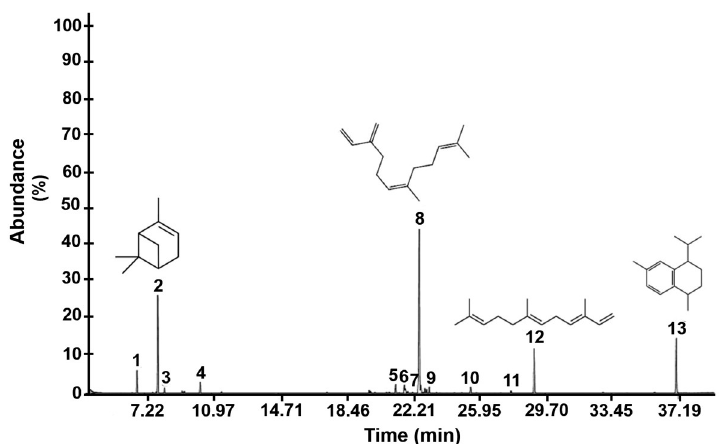
Figure 1. Chromatogram of the hexanic extract of E. carlinae inflorescences. (1) α -Pinene; (2) β -Pinene; 3) β -Mircene; 4) γ -Terpinene; 5) α -Bergamotene; 6) (E) β -Farnesene; 7) α -Cariofilene; 8) Z β -Farnesene; 9) Eudesmadiene; 10) Carotol; 11) α -Bergamotol; 12) α -Farnesene; 13) Calamanene.